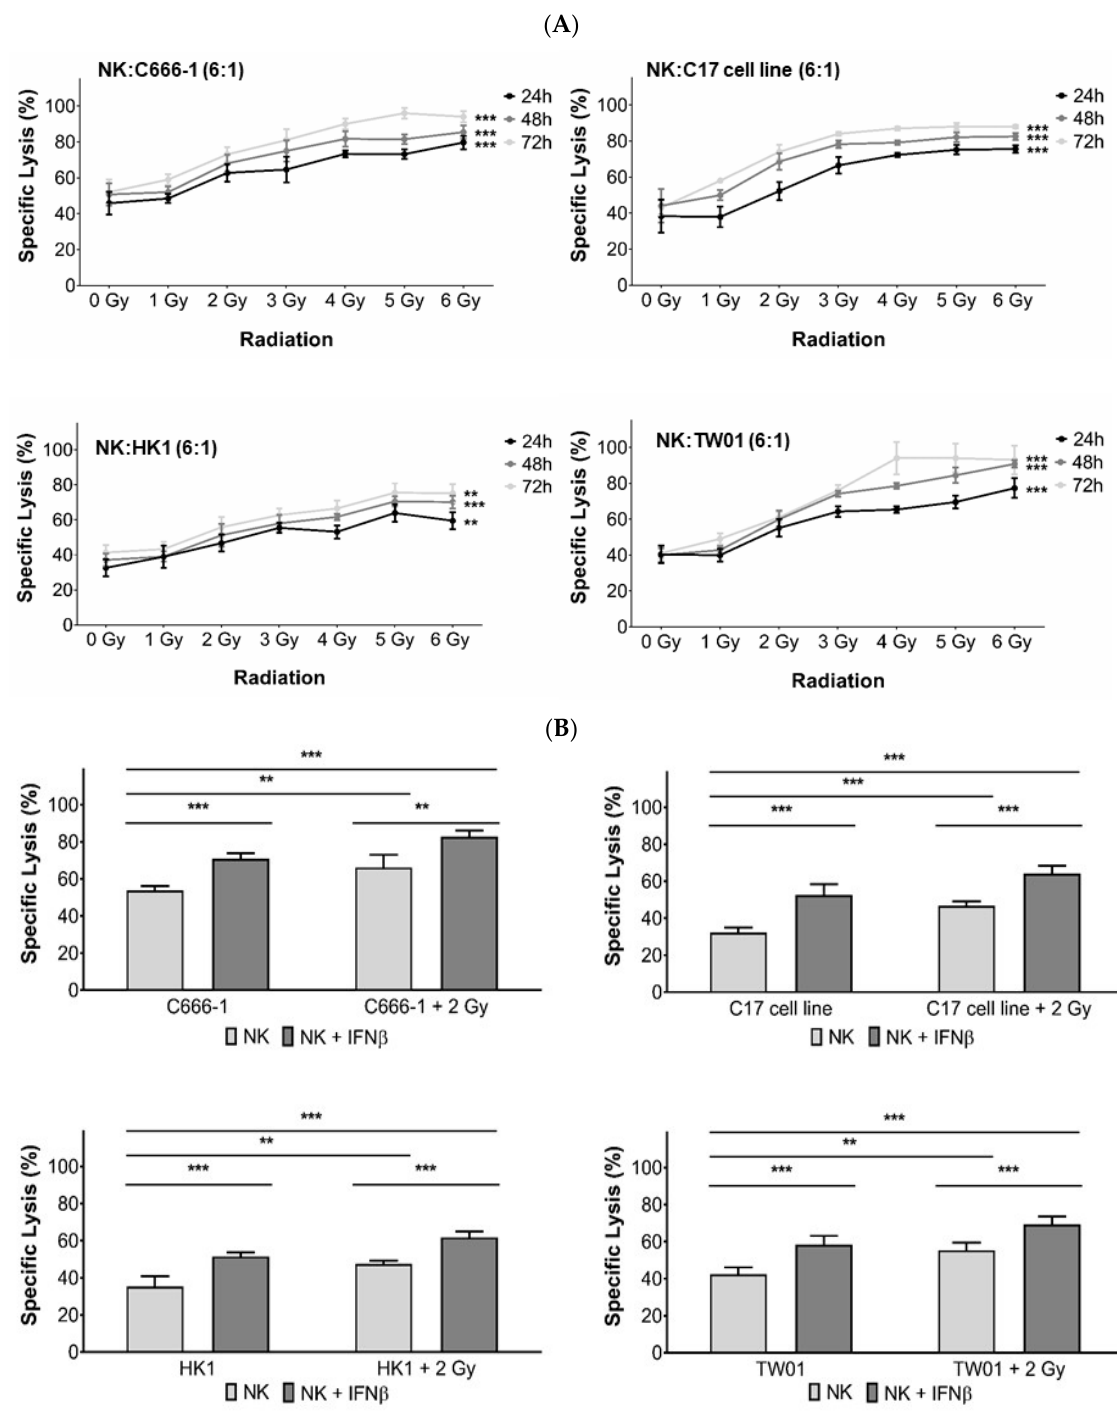
Figure 1. Radiotherapy sensitizes NPC cells to killing by NK cells. NPC cells were irradiated with doses from 0 to 6 Gy and cultured thereafter for 24, 48 or 72 h in medium. Cells were then labeled with calcein, plated in a 96-well plate and incubated with NK cells for 4 h at an E:T ratio of 6:1. ( A ) Lysis of target cells was determined by the measurement of calcein in collected supernatants by an ELISA reader. ( B ) NK cells were pre-incubated or not with IFN β (1000 U/mL) for 24 h and then co-incubated with NPC cells irradiated or not with 2 Gy and cultured for 24 h as above. Data are presented as means ± S.E.M. Asterisks indicate statistically significant differences between the non-irradiated group and irradiated groups in all cell lines (a: two-way ANOVA; b: one-way ANOVA; ** p < 0.01; *** p < 0.001). As we had previously demonstrated, that the activation of NK cells with IFN β sig- nificantly increased their killing of NPC cells [15,16,24], we further investigated whether